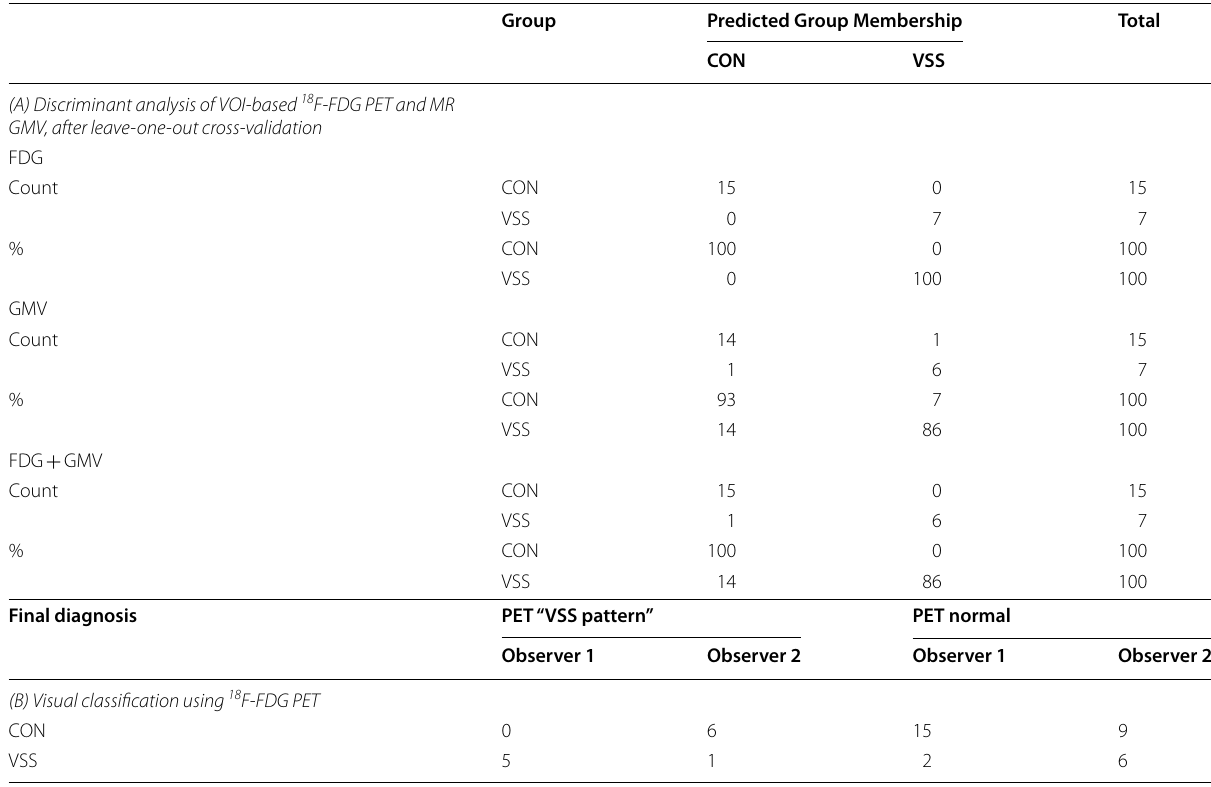
CON healthy controls; VSS =